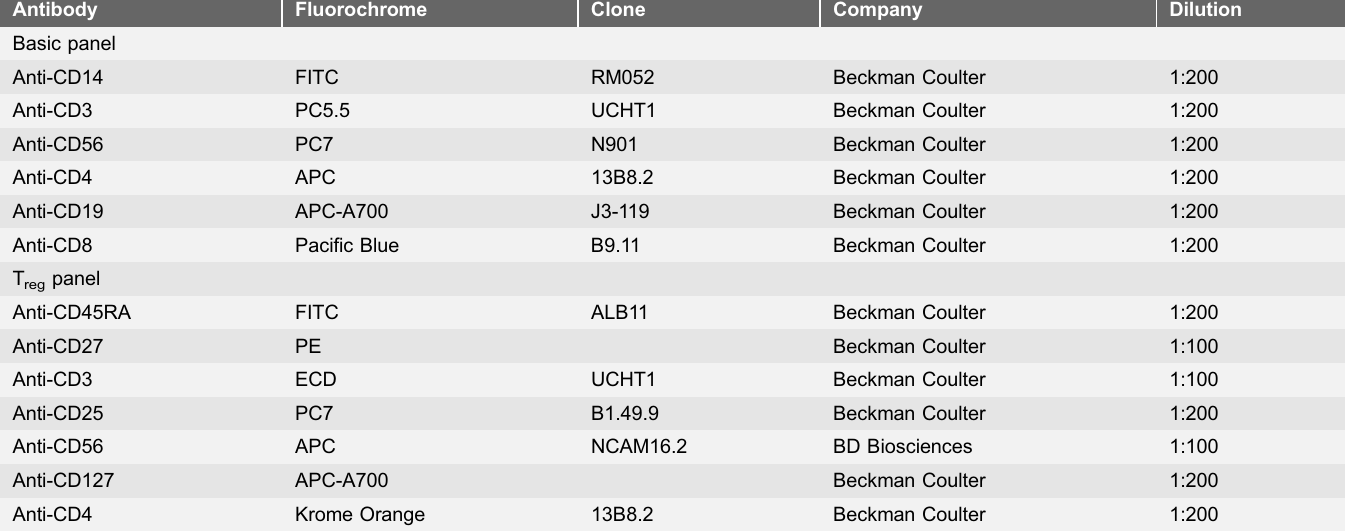
Table 1. Antibody composition of staining master mix (basic panel and T reg panel) applied for multicolor flow cytometry.